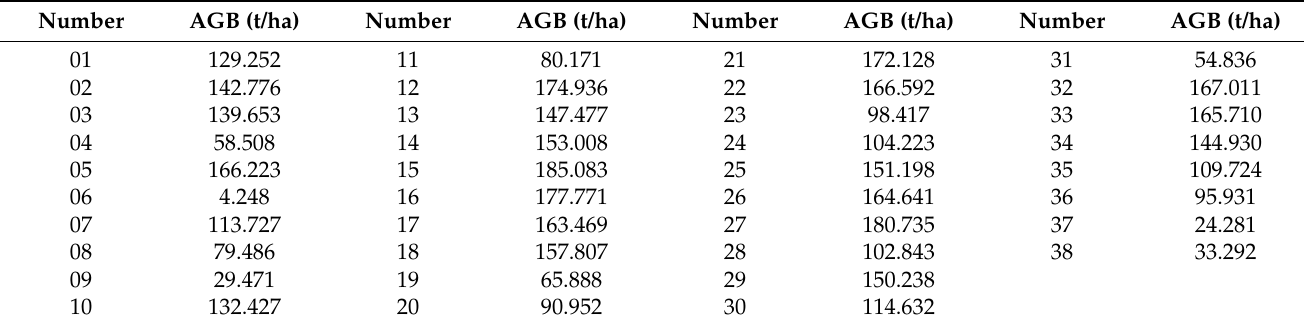
Table 1. Statistical data of the plots.